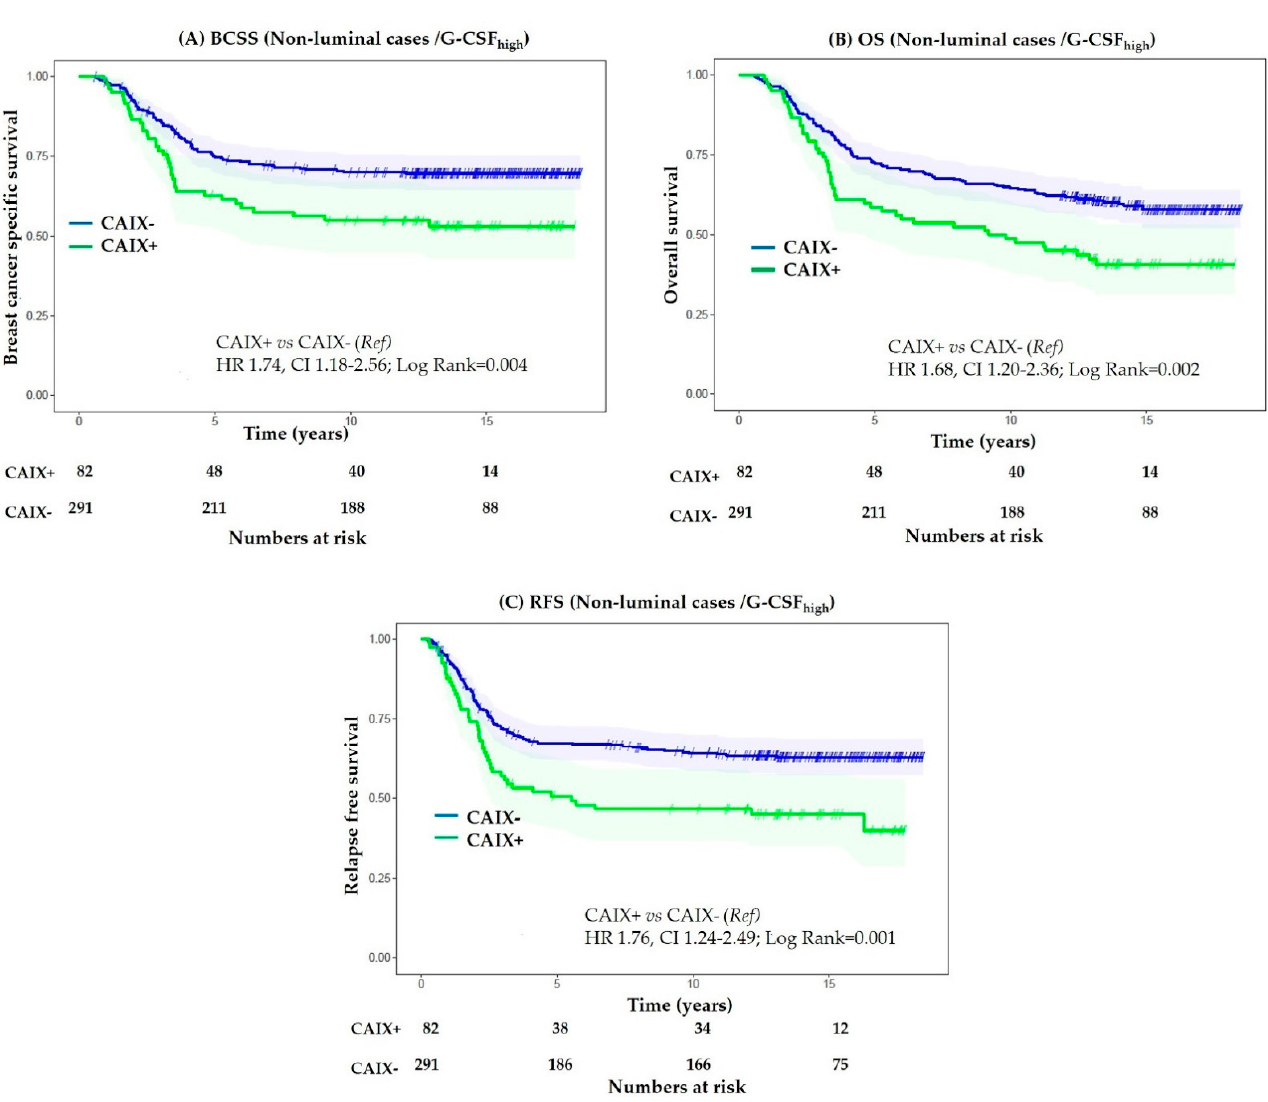
Figure 4. Kaplan–Meier curves for association of CAIX expression in non-luminal cases with G-CSF high phenotype. Expression of CAIX is associated with adverse breast cancer-specific survival ( A ), overall survival ( B ), and relapse-free survival ( C ).